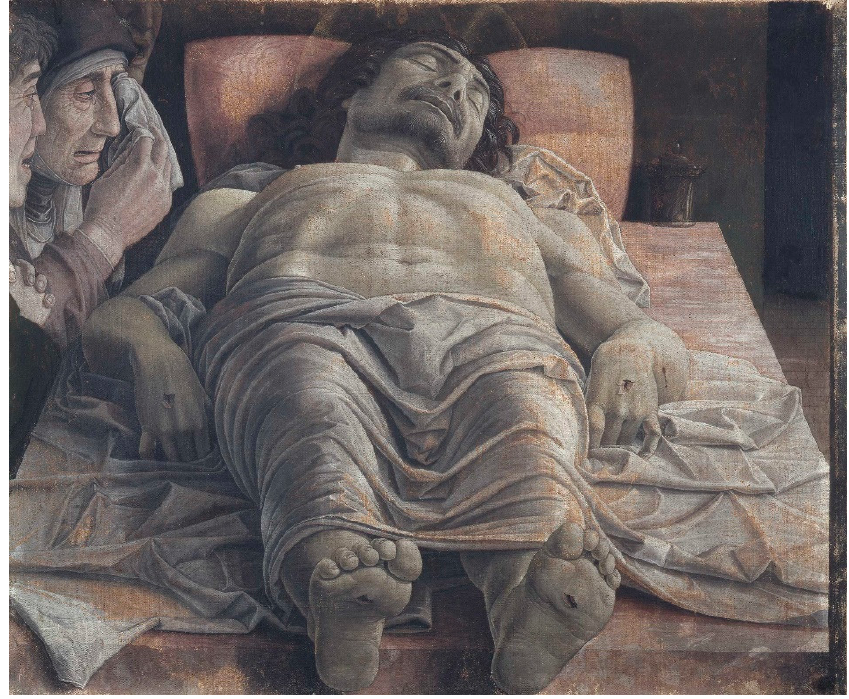
Figure 2. Andrea Mantegna, Lamentation of Christ (c. 1480), Pinacoteca di Brera,